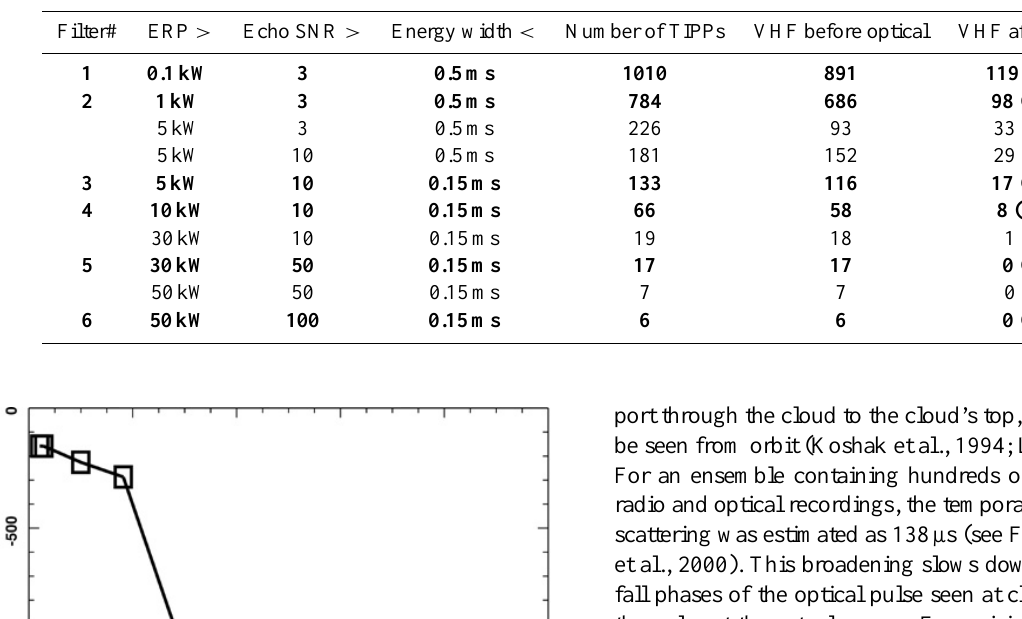
Table 3. HUMR TIPP filters shown in bold type. When more than one parameter is varied between adjacent TIPP filters, the contributions of varying each parameter individually are shown in the remaining rows (non-bold type).